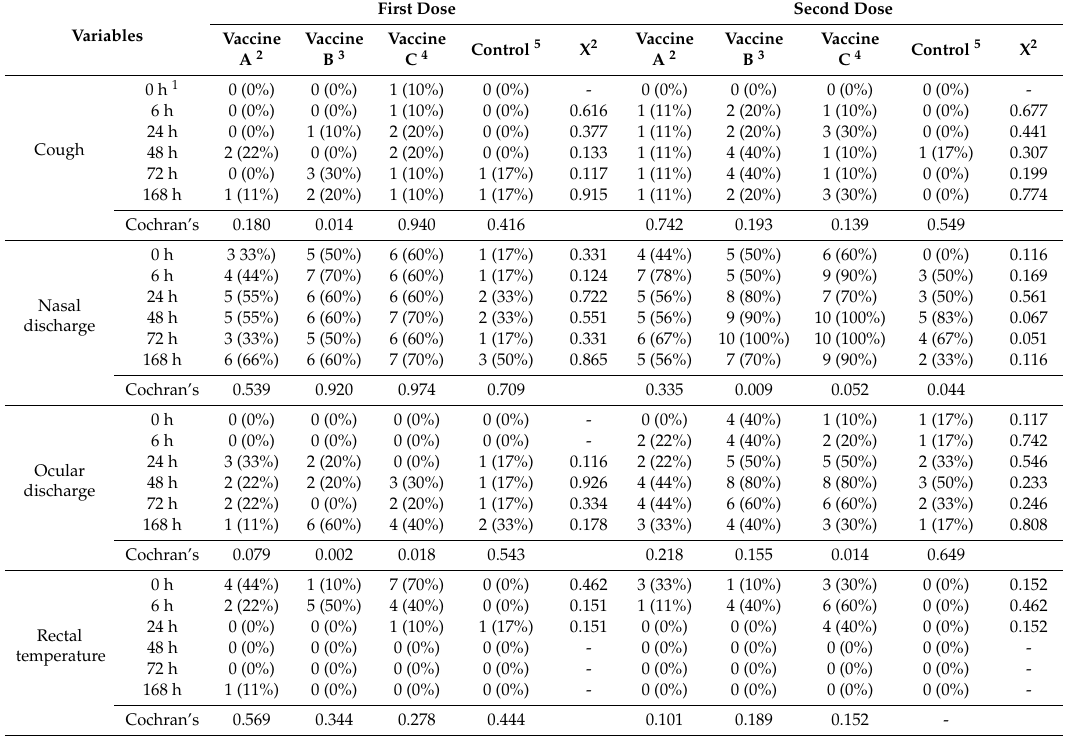
Table A2. Impact of systemic reaction based on respiratory score, rectal temperature, fecal consistency and sum of health score induced by vaccines against BVDV and BHV-1 with different commercial